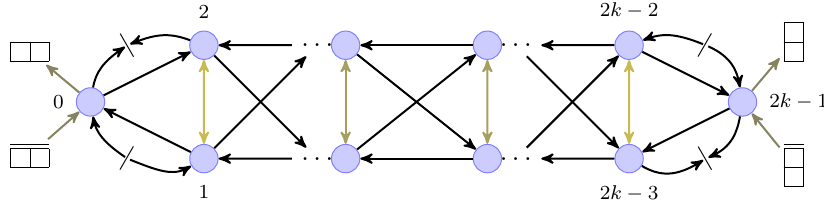
Figure 22. The generic quiver of family A models. Colored fields are the mass deformed pairs. All gauge nodes are SU( N ) .